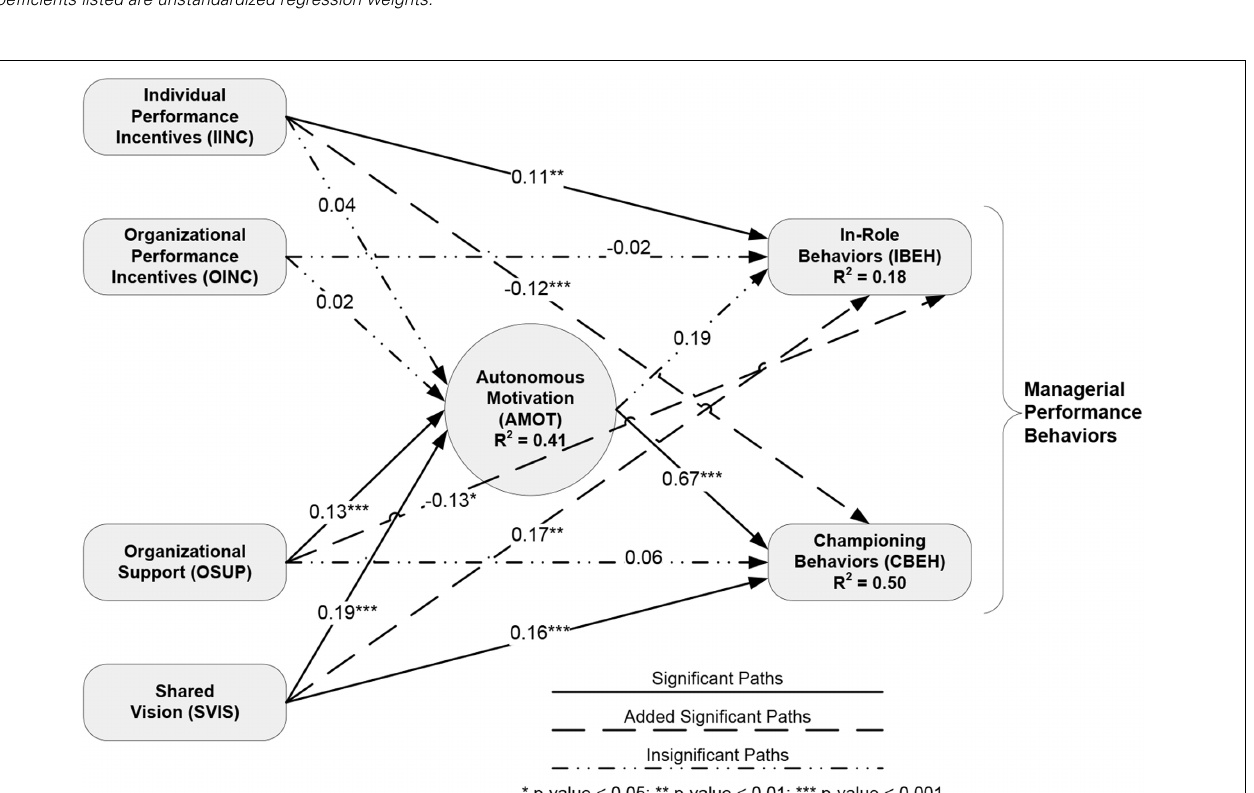
for senior vs. middle managers and 0.083 for managers under vs. over 45 years